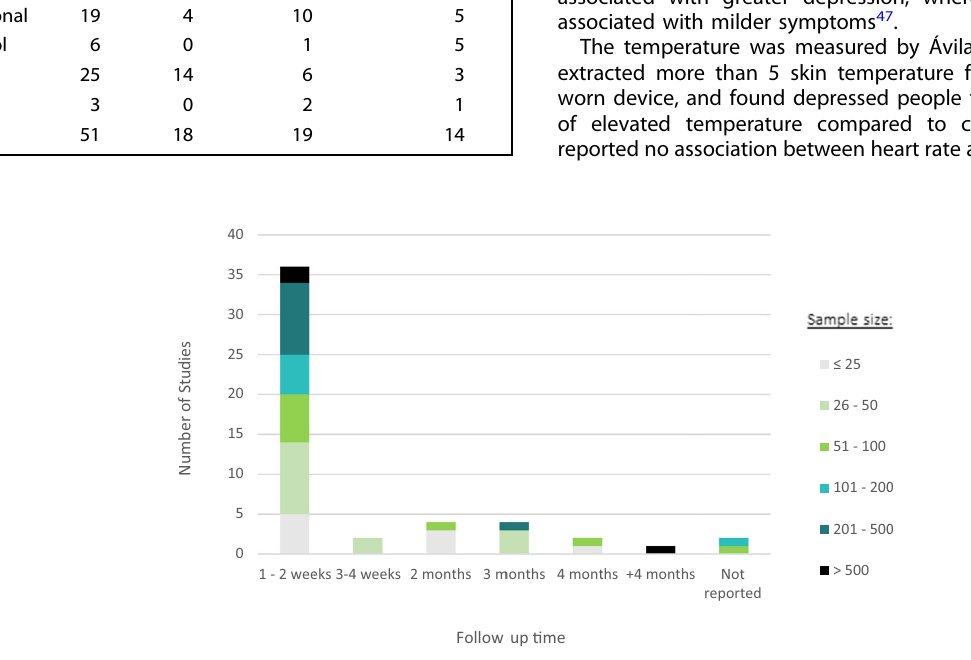
Fig. 2 Sample sizes and follow-up times for all included studies. The number of studies by the length of time participants were followed up for in each study, differentiated by sample size.